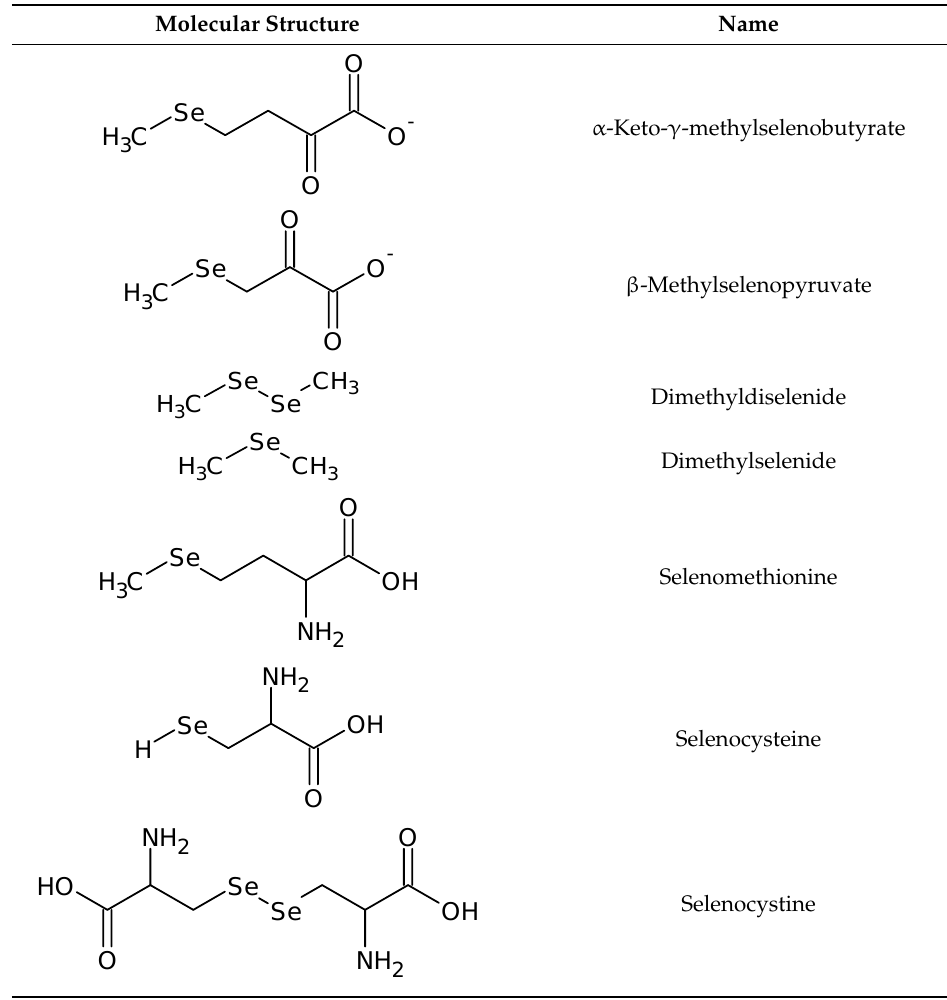
Table 2. Organic forms of Table 2. Organic forms of selenium. Table 2. Organic forms of selenium. Molecular Structure Table 2. Organic forms of selenium. Table 2. Organic forms of selenium. Molecular Structure Table 2. Organic forms of selenium.